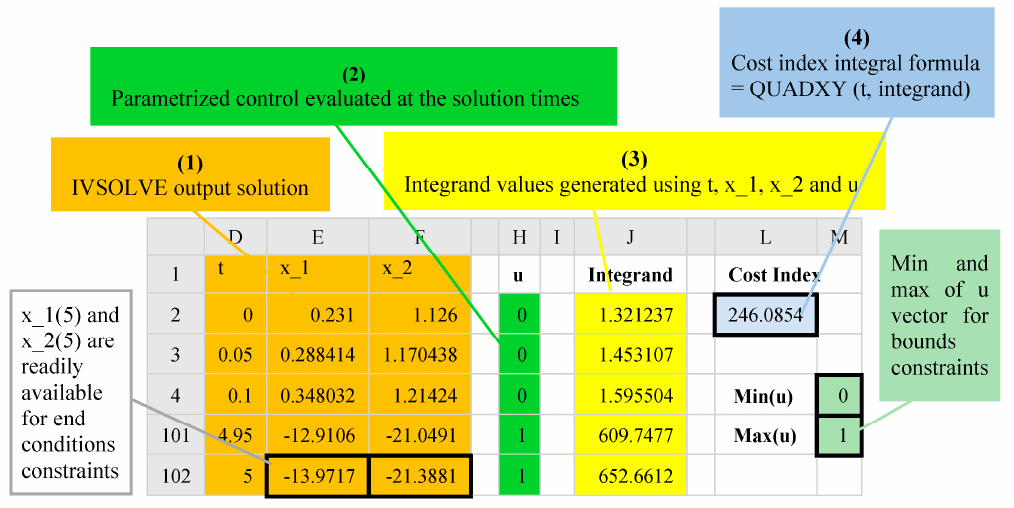
Figure 2. Illustration of the ordered steps for defining an analogous objective formula to the cost index functional (1). The illustration assumes a problem with two state variables and one control.